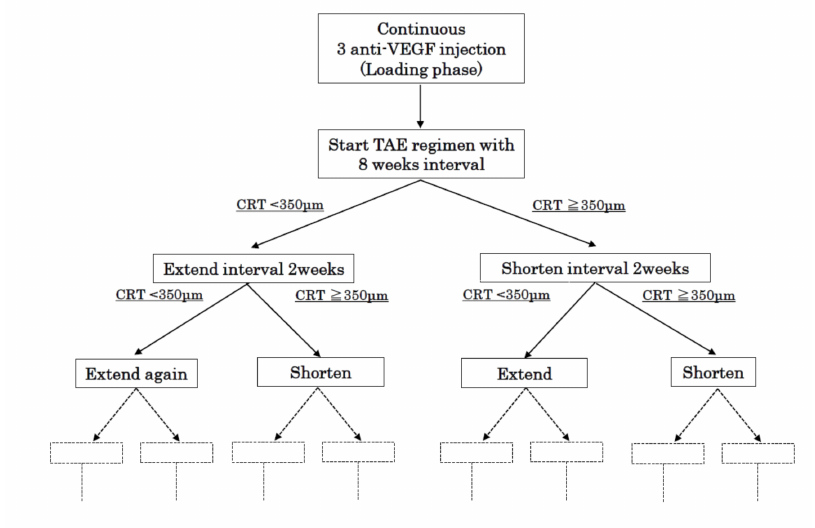
Figure 2. Modified-TAE regimen for diabetic macular edema (DME). All patients were given 3 consecutive monthly injections and they continued IVR or IVA with a modified TAE regimen. The initial treatment interval after the loading phase was set at 8 weeks. The injection interval was extended by 2 weeks if the central retinal thickness (CRT) was < 350 µ m at 2 consecutive examinations, and the injection interval was shortened by 2 weeks if CRT was ≥ 350 µ